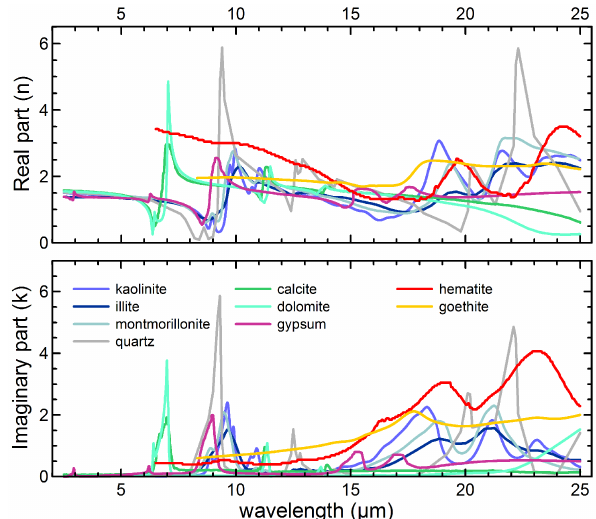
Figure 3. Real ( n ) and imaginary ( k ) parts of the complex refractive index within the spectral range 2.5–25µm for individual minerals composing the dust. References for the plotted curves are: kaolin- ite (Glotch et al., 2007), illite (Querry, 1987), montmorillonite (a mineral of the smectite family, taken here as representative for this clay species) (Glotch et al., 2007), quartz (Peterson and Weimn- man, 1969), calcite (Querry et al., 1978; Long et al., 1993), dolomite (Querry, 1987), gypsum (Long et al., 1993), hematite (Marra et al., 2005), and goethite (Glotch and Rossman, 2009). No literature data are available for feldspars (orthose and albite) at infrared wave- lengths. The colour code used for the different minerals is indicated in the legend in the bottom